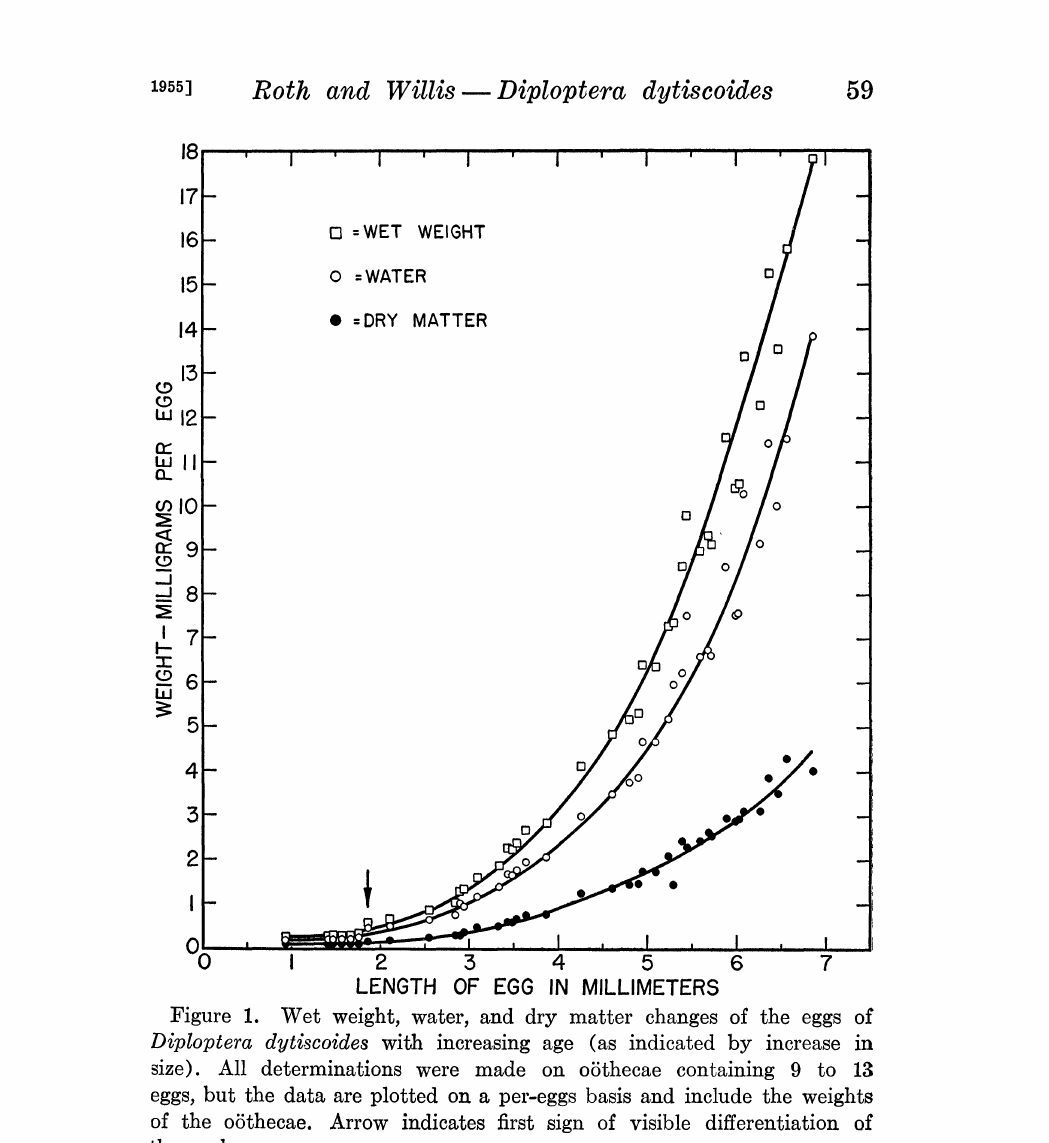
Figure 1. Wet weight, water, nd dry matter changes of the eggs of Diploptera dytiscoides witch increasing age (as indicated by increase in size). All determinations were made on oSthecae containing 9 to 13 eggs, but the dat re plotted oz a per-eggs bsis nd include the weights of the oSthecae. Arrow iadictes first sign of visible differentiation of the